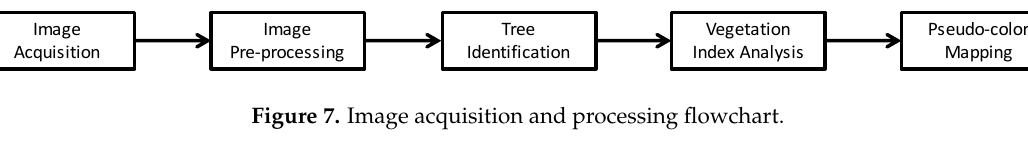
Figure 7. Image acquisition and processing flowchart. Table 2. Vegetation indices for image analysis.